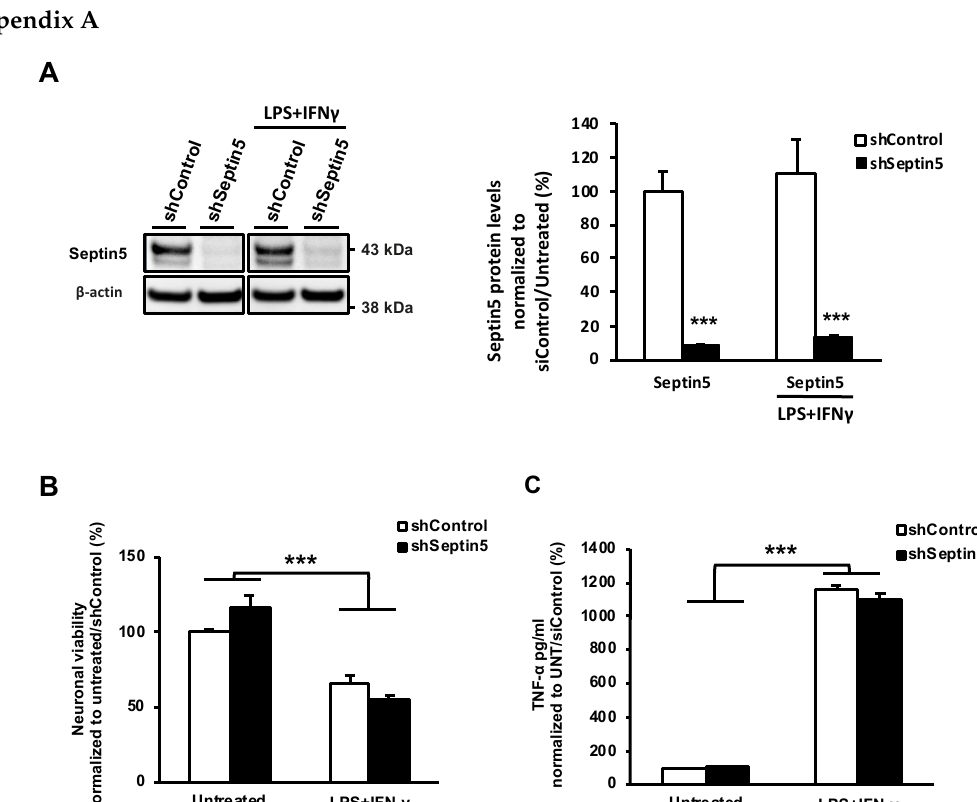
Figure A1. Downregulation of Septin5 does not affect neuronal viability in mouse primary cortical neuron-BV2 microglia co-cultures. ( A ) Western blot analysis showed a significant reduction in the levels of Septin5 in untreated and lipopolysaccharide (LPS-) and interferon- γ (IFN γ )-treated neuron-BV2 microglia co-cultures as compared with the control co-cultures. Protein levels were normalized to β -actin and are shown as a % of siControl; ( B ) Neuronal viability was significantly decreased after LPS/IFN γ treatment as compared with the untreated (UNT) controls; ( C ) The levels of TNF- α were significantly increased by treatment with LPS/IFN γ as compared with the untreated controls, confirming the induction of neuroinflammation owing to treatment with LPS/IFN γ .(A) n = 4, mean ± SEM, independent t-test. ( B ) n = 4, mean ± SEM, one-way ANOVA, post hoc LSD. *** p < 0.001.